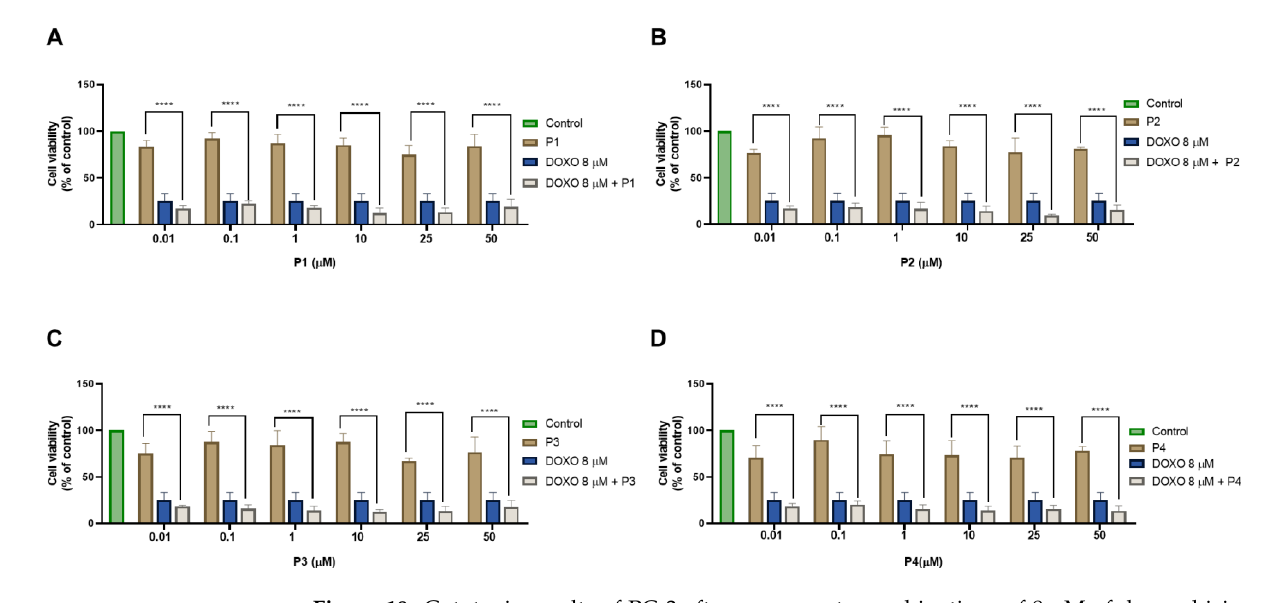
Figure 18. Cytotoxic results of PC-3 after exposure to combinations of 8 µ M of doxorubicin with increasing concentrations of the peptides ( A ) P1, ( B ) P2, ( C ) P3, and ( D ) P4 (0.01–50 µ M) for 48 h. Control cells were treated with 0.01% DMSO (vehicle). Cell viability was obtained using the MTT assay, and the results are given as the mean ± SEM ( n = 3). **** Statistically significant vs. drug alone at p < 0.0001.